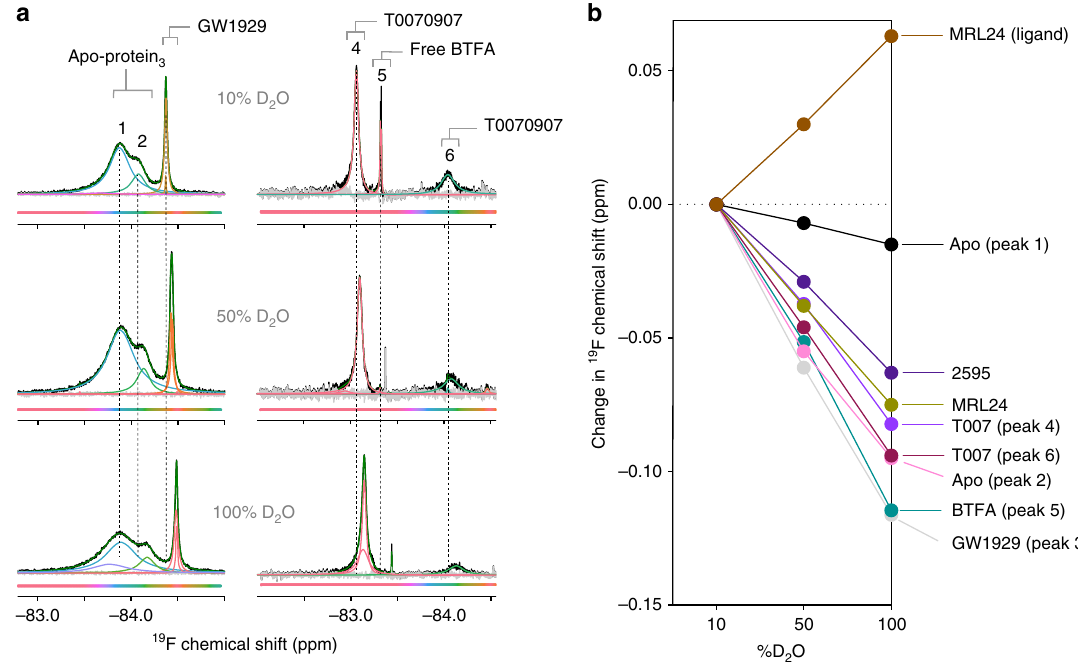
Fig. 3 Helix 12 solvent exposure is distinct for the active and inactive helix 12 conformations. a 19 F NMR spectra of delipidated apo PPAR γ C313A,K502C -BTFA bound to 0.2 molar equivalent of GW1929 (left), and T0070907-bound PPAR γ K502C -BTFA with excess free BTFA, at the indicated concentrations of D 2 O. Due to the high binding af fi nity of GW1929 (4 nM), all three expected peaks (two apoprotein peaks and one GW1929 peak) are present in slow exchange on the NMR time scale, allowing analysis of the three conformations simultaneously. b D 2 O solvent isotope-induced changes, plotted as % D 2 O vs. change 19 F NMR chemical shift values for various peaks; a dotted gray line is shown to highlight no D 19 F NMR chemical shift. These 2 O-induced change in experiments were performed